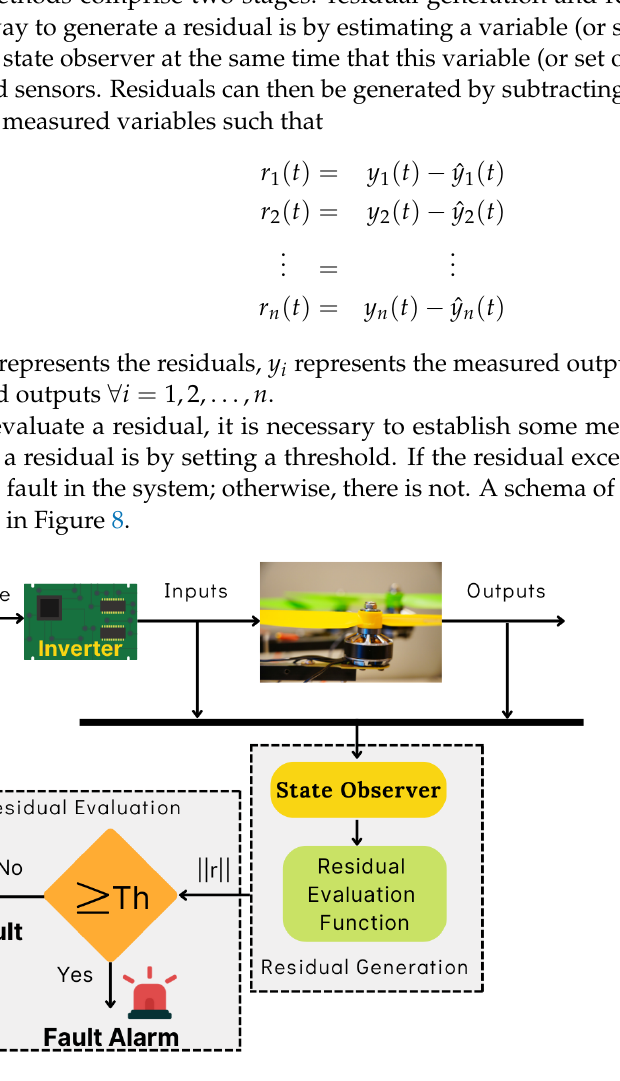
Figure 8. Usual architecture of methods based on residuals for diagnosing faults in the stators of BLDC